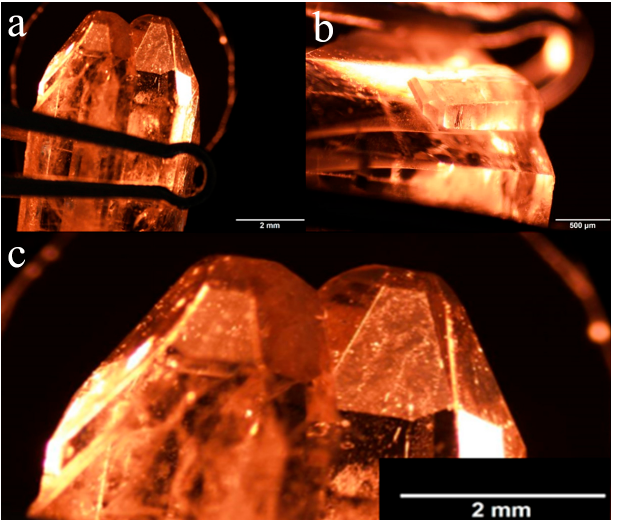
Figure 2. ( a ) The well-developed twin crystal of TO9. ( b ) Overgrowth can be seen in TO7. ( c ) A set of {001} perfect cleavage of